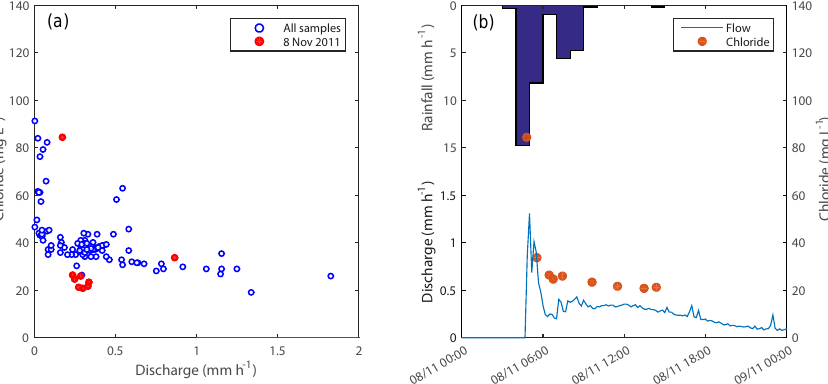
Figure 10. (a) Discharge vs. Cl − concentration for all events. The red colour identifies samples from the event on 8 November 2011. (b) Time series of rainfall, runoff and Cl − concentration for the event on 8 November